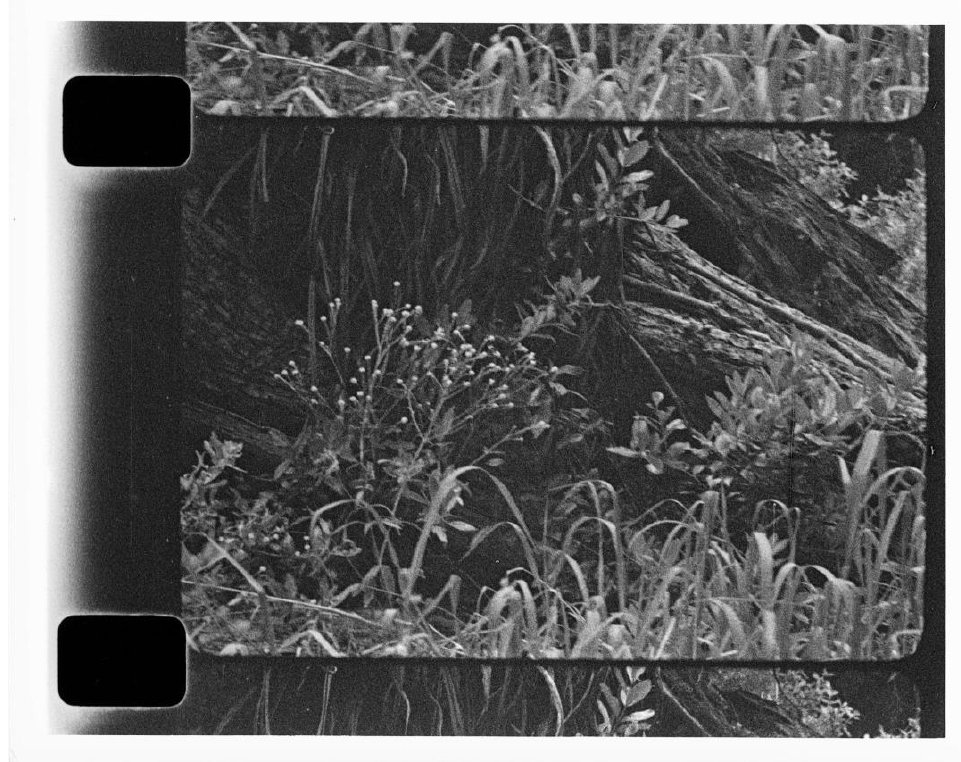
Figure 4. Nova Paul, Rākau , 2022, 16mm film print.